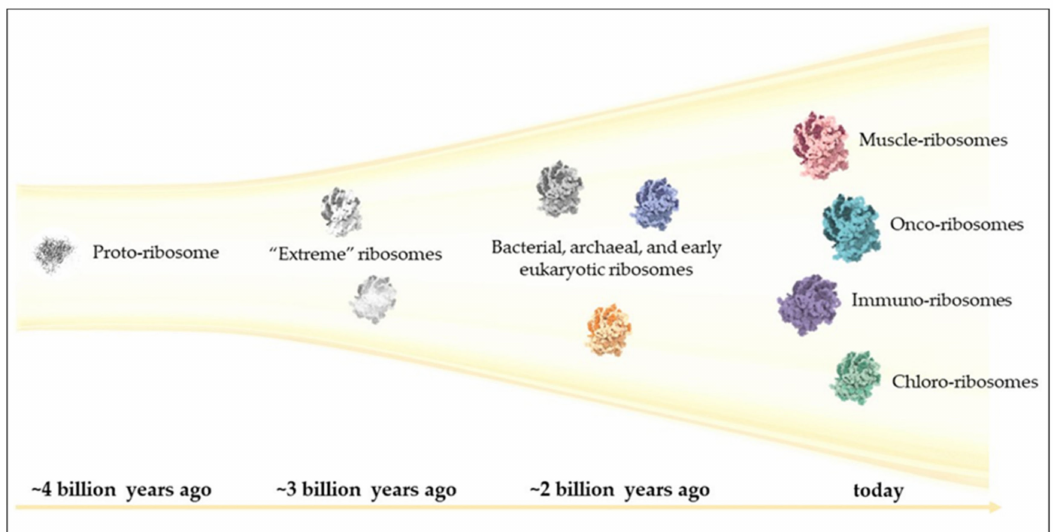
Figure 2. The expanding riboverse. The primordial ribosomal core, the proto-ribosome, is thought to have evolved approximately 4 billion years ago, marking the “Big Bang” of the riboverse. This ancient molecule continued to structurally and functionally evolve along with cellular evolution, diversifying and specializing to thrive in an increasing number of environments. Recent evidence suggests that in addition to inter-species specialization, ribosomal diversity also exists at the intra-organismal